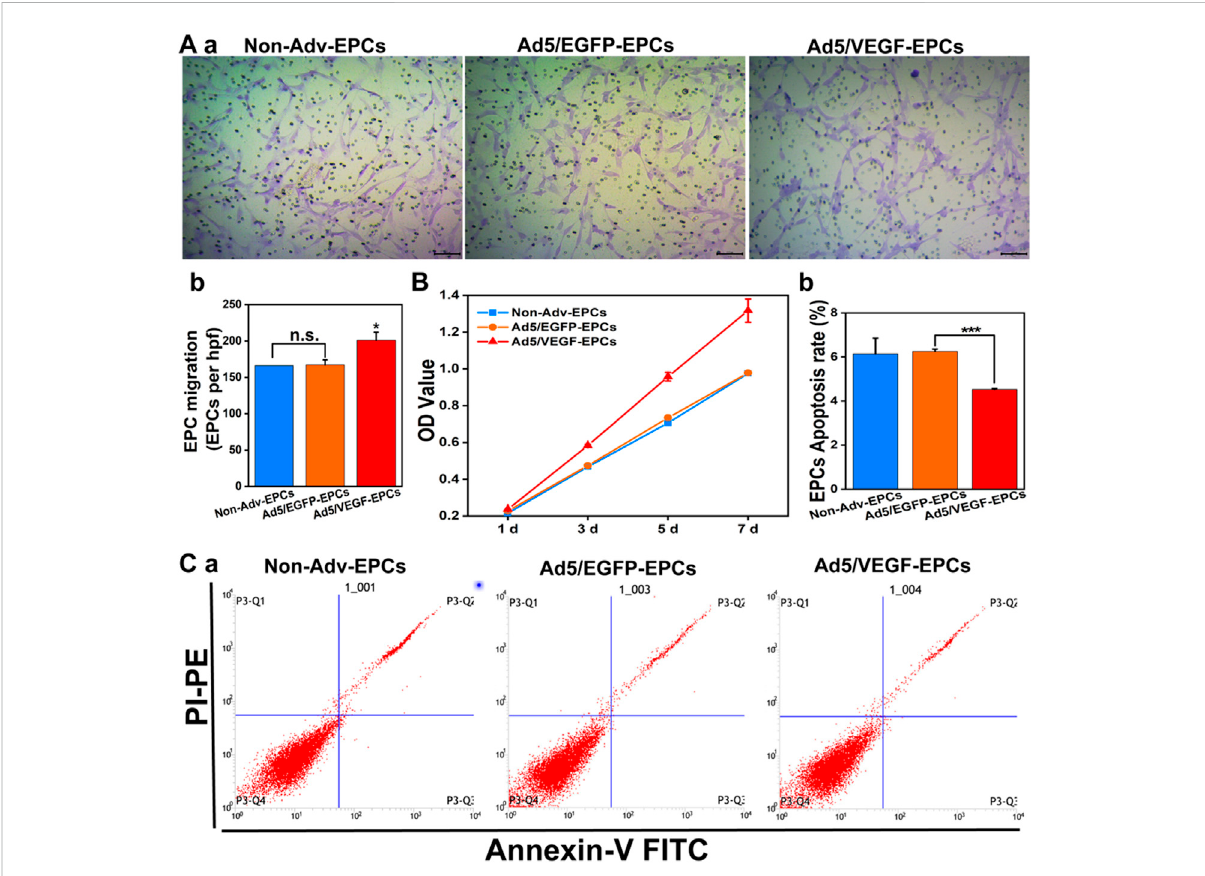
FIGURE 3 VEGF expression increases proliferation and migration, and decreases apoptosis of EPCs. (A) Representative images showing cell migration (a); BargraphindicateshighmigrationrateofAd5/VEGF-EPCs(b). (B) ProliferationcapacityofAd5/VEGF-EPCswashigherthanthatofnon-Adv-EPCsor Ad5/EGFP-EPCs on days 1, 3, 5, and 7 after transduction. (C) Apoptotic rate of EPCs was analyzed by FCM using Annexin V/propidium iodide (PI) staining. Apoptotic cells are de fi ned as Annexin V+/PI- (Quadrant three and 4) (a); (b) Apoptosis rate of Ad5/VEGF-EPCs was signi fi cantly lower than that of non-Adv-EPCs or